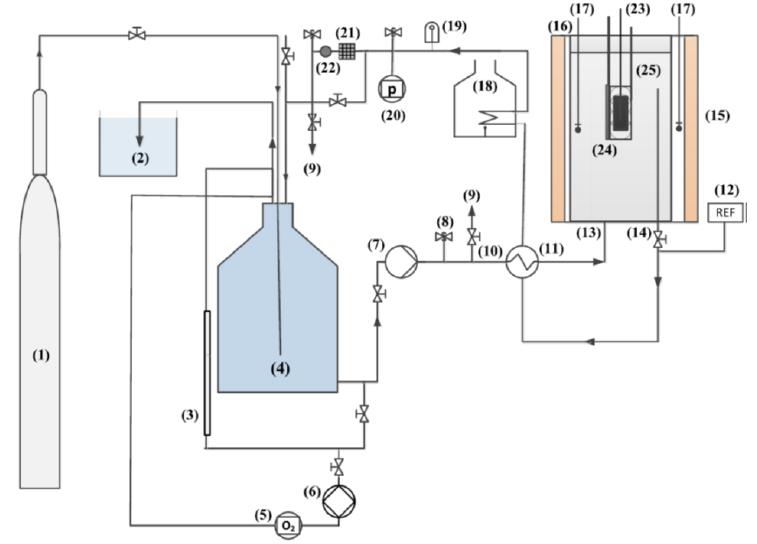
Figure 3. Experimental loop: (1) argon bottle, (2) water closure, (3) level measurement, (4) storage vessel, (5) oximeter, (6) pump of oximeter, (7) pressure pump, (8) safety valve, (9) and (10) valve, (11) preheating, (12) reference electrode, (13) entry into the autoclave, (14) output from the autoclave, (15) autoclave, (16) heating, (17) temperature sensors, (18) cooler, (19) hydro-accumulator, (20) pres- sure sensor, (21) filter, (22) pressure control, (23) working electrode, (24) pseudo-reference electrode, (25) counter